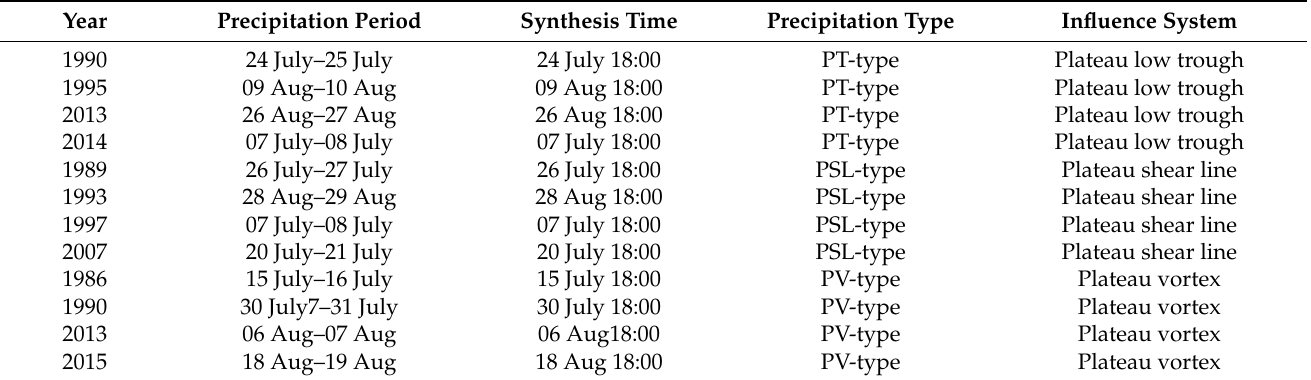
Table 2. Synthetic case information